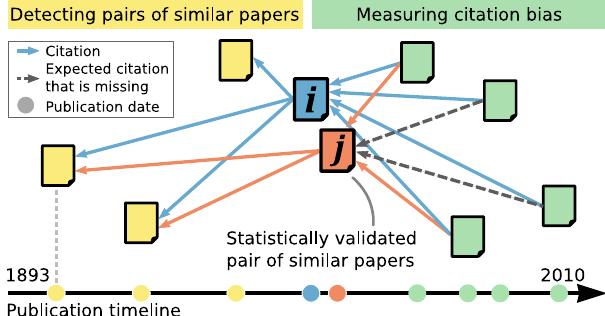
Fig. 2 Assessing similar pairs. We use bibliographic coupling and hypergeometric statistical tests to select couples of similar papers based on their outgoing citation activities. Then we compare their respective popularity (incoming citations). Each node and each arrow represent a paper and a citation respectively, whereas each dashed arrow represents a potential citation that is missing. The pair of papers being assessed ( i and j ) are shown in blue and orange, the papers cited by them in yellow, and the papers that cite them in green. The black arrow at the bottom represents a timeline showing the publication times of the